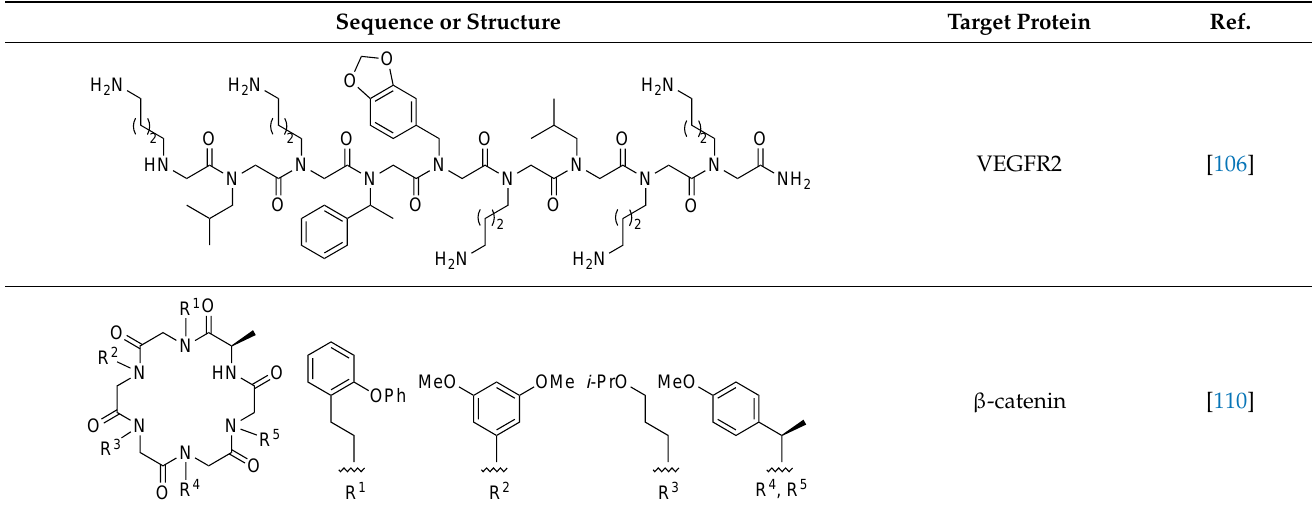
Table 4. Peptoid-based PPI inhibitors. Sequence or Structure Target Protein